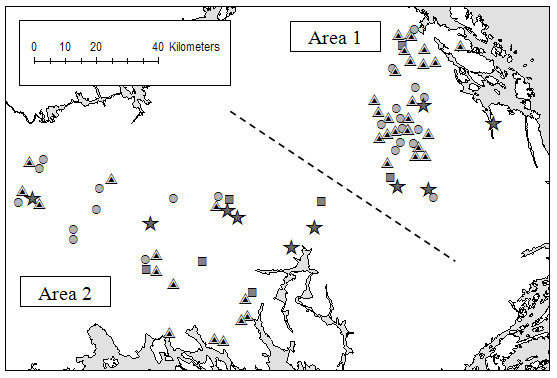
Geographical distribution. Geographical distribution of 79 Swedish dairy herds, stratified by antibody-status to bovine coronavirus (BCV) and bovine respiratory syncytial virus (BRSV) as measured by an ELISA test in pooled milk samples of 5 primiparous cows sampled in September-October 2006. Star = Negative for BRSV and BCV Circle = Positive for BRSV, negative for BCV Square = Negative for BRSV, positive for BCV Triangle = Positive for BRSV and BCV